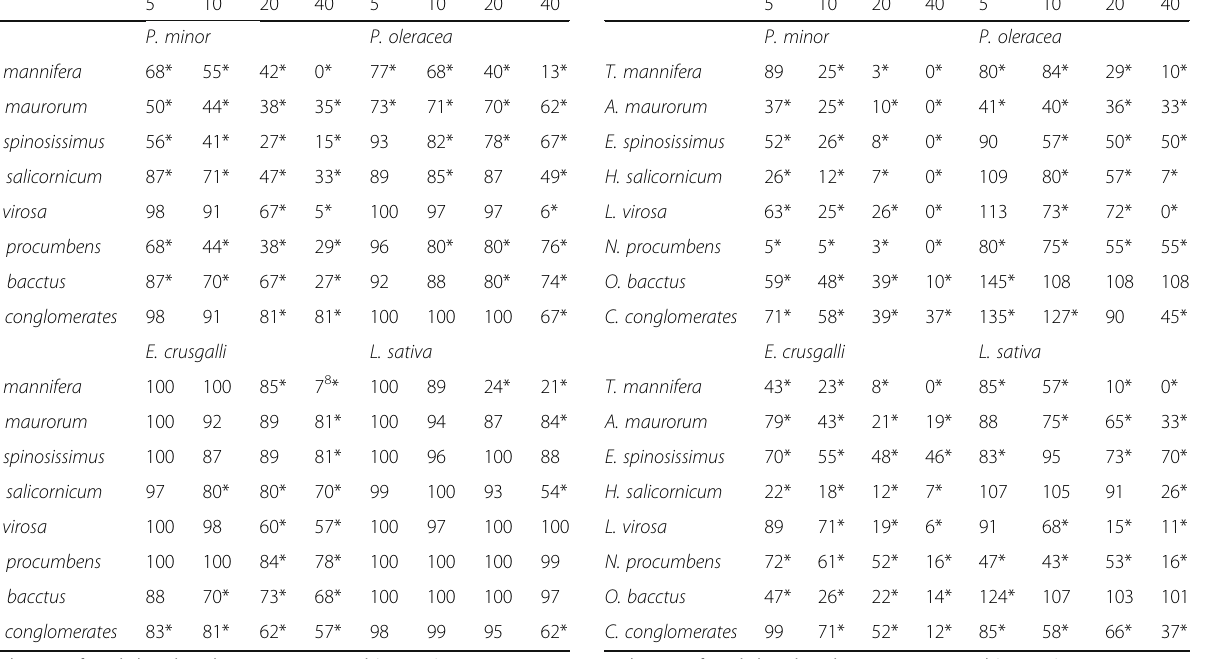
Table 1 Effect of plant extracts (% of control) on germination percentage of P. minor , P. oleracea , E crusgalli , and L. sativa Plant species Extract concentration (g/L)